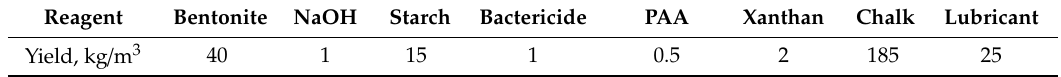
Table 7. Optimal composition of the washing liquid.